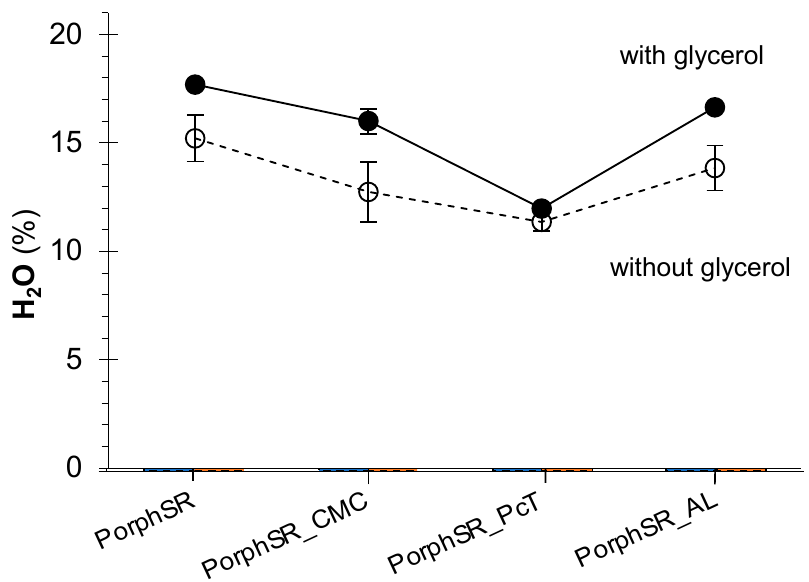
Figure 5. Moisture contents (Equation (1)) in the produced films. (Clear symbols: compositions without glycerol; full symbols: compositions with glycerol.)